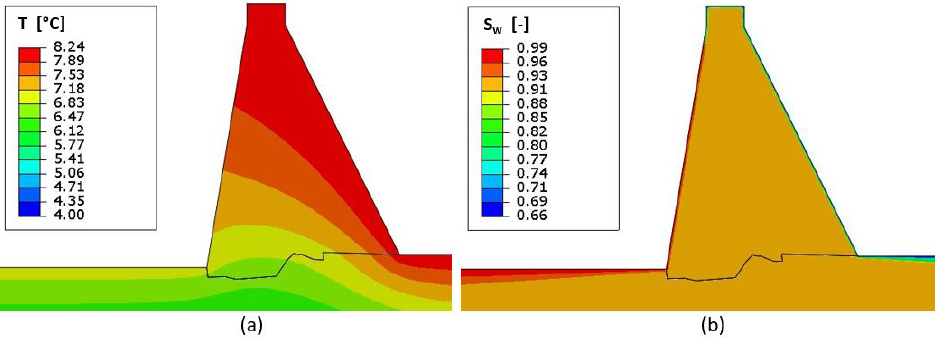
Figure 11. Contour plots: ( a ) Stabilized temperature (in ◦ C) and ( b ) stabilized saturation degree.